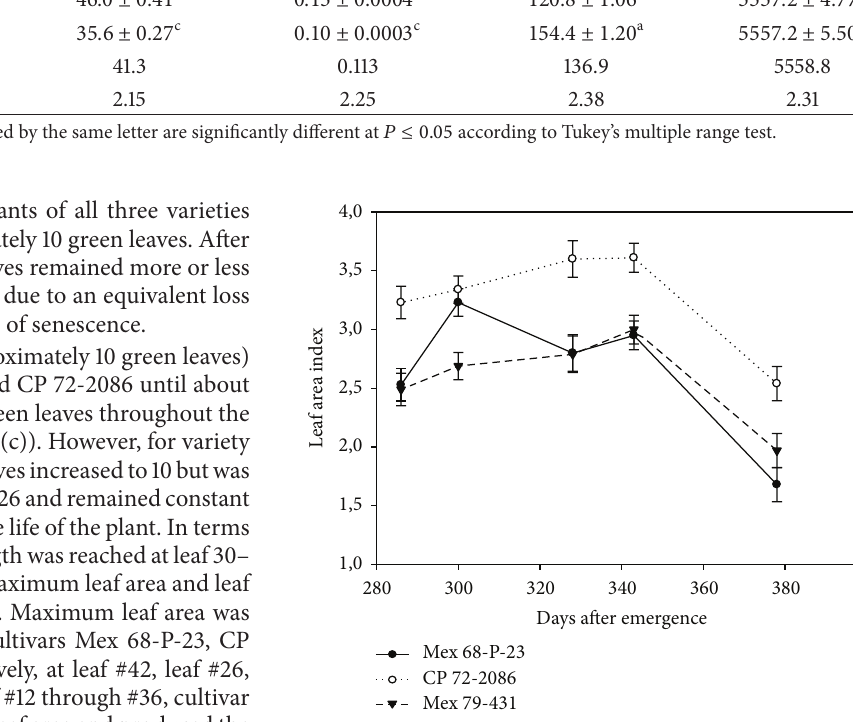
Figure 3: The progress of leaf area index with time for three sugarcane cultivars sown on the same date during the period canopy closure to harvest under high temperature rainfed conditions in Northeastern